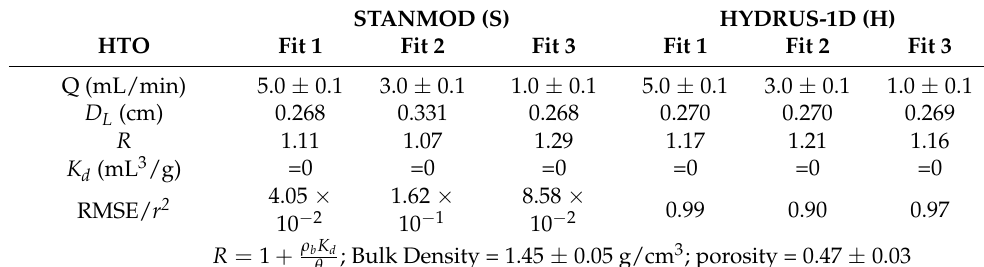
Figure 4. The HTO breakthrough curves (BTCs) at various flow rates. ( a ) 5.0 ± 0.1 mL/min; ( b ) 3.0 ± 0.1 mL/min; ( c ) 1.0 ± 0.1 mL/min. Table 3. The parameters for fitting HTO